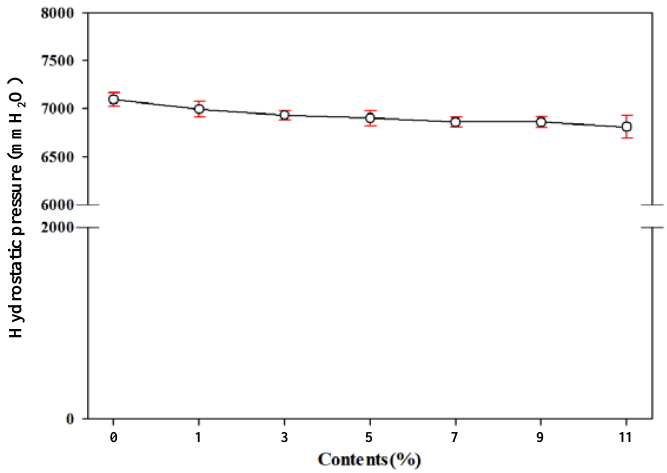
Figure 10. Hydrostatic pressure by high pressure tester of polyester thermoplastic film with various contents of thermally expandable microcapsules.